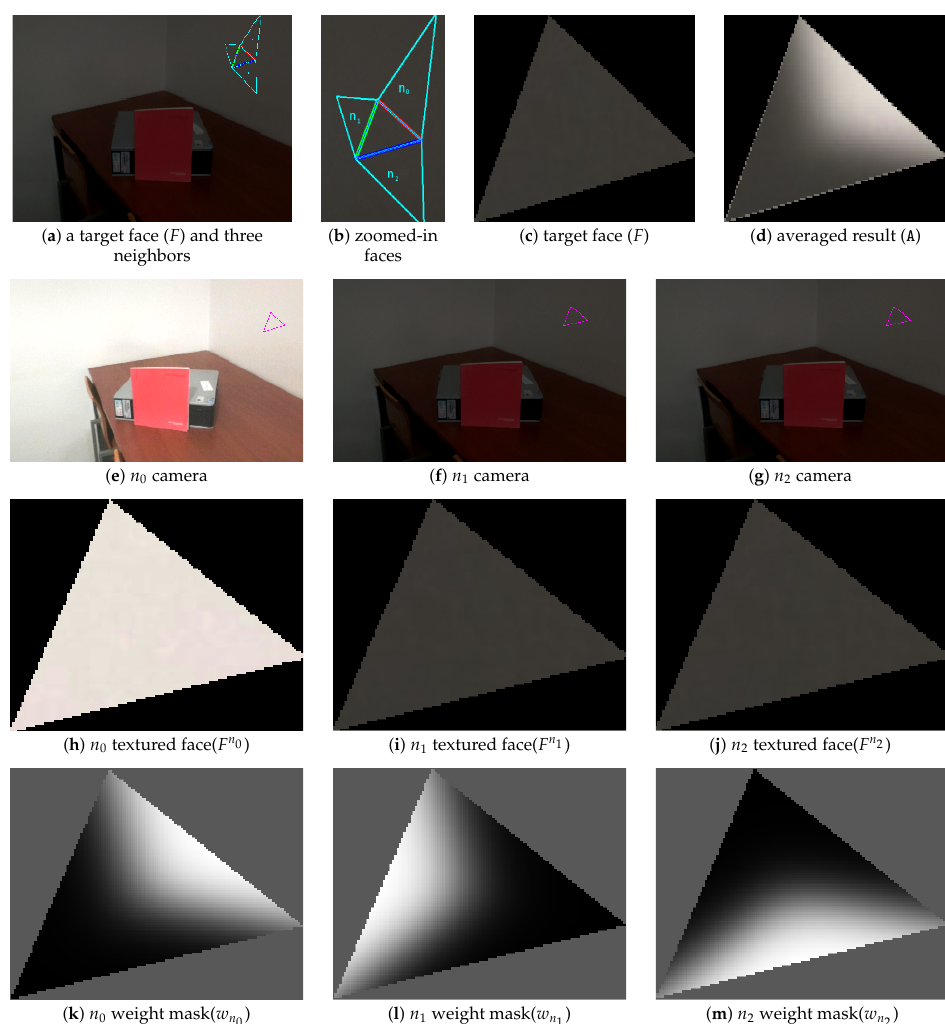
Figure 9. Example of the proposed smoothing